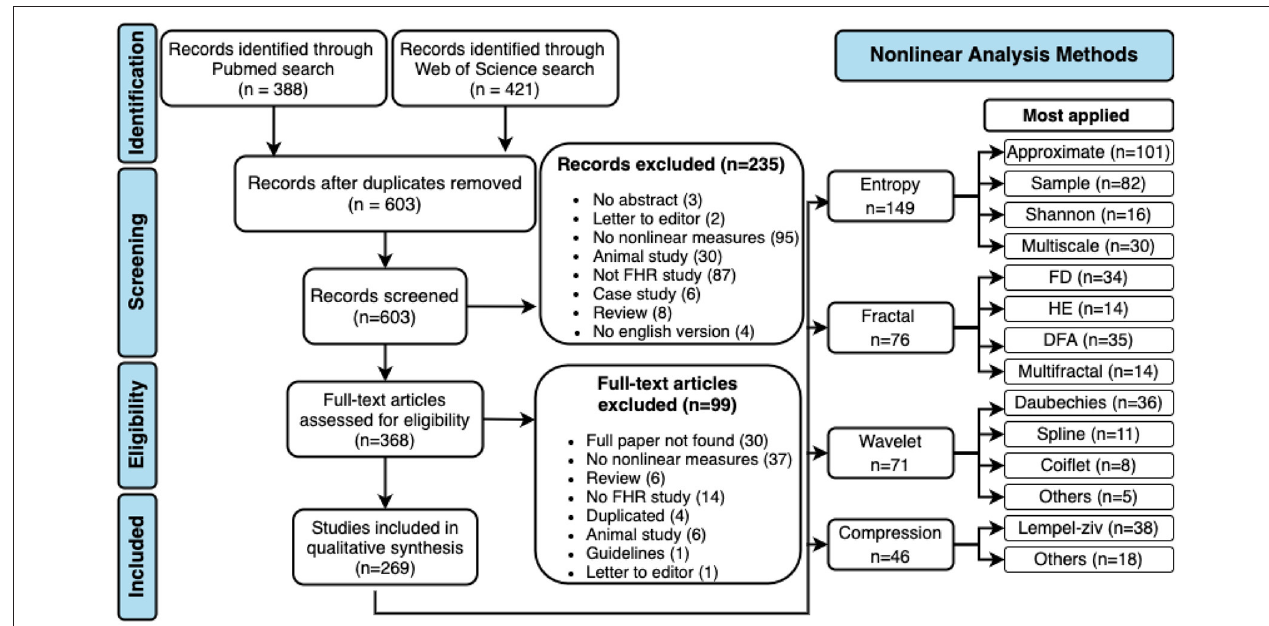
FIGURE 1 | PRISMA flow diagram and non-linear methods most applied in fHR. DFA, detrended fluctuation analysis; FD, fractal dimension; HE, Hurst exponent.